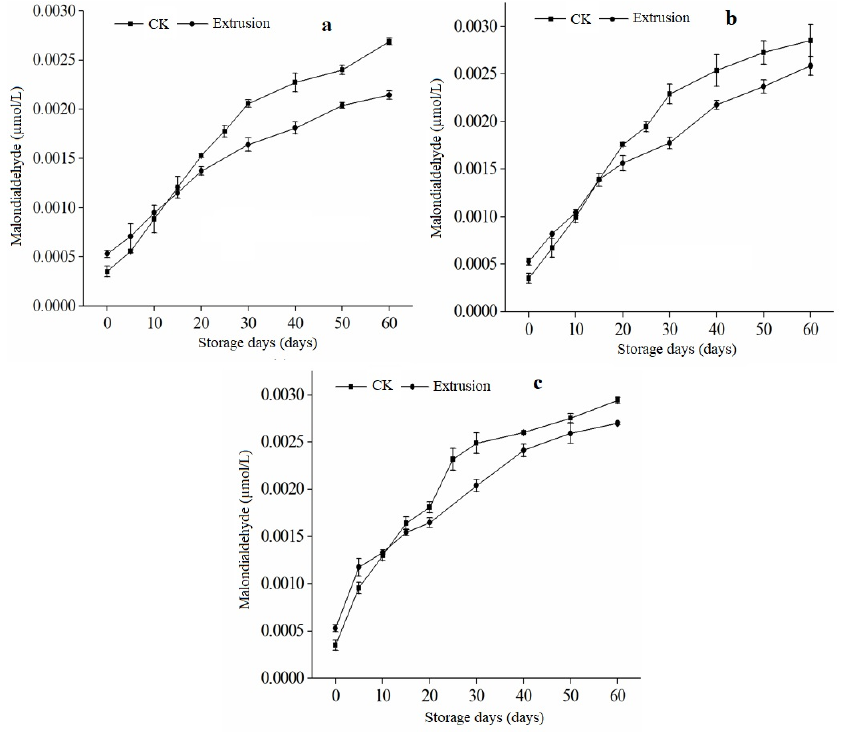
Figure 6. Changes in malondialdehyde content of rice bran treated by extrusion. Note; ( a ), ( b ), and ( c ) in the figure refer to the storage temperature of 15 °C, 25 °C, and 40 °C; CK is untreated rice bran.